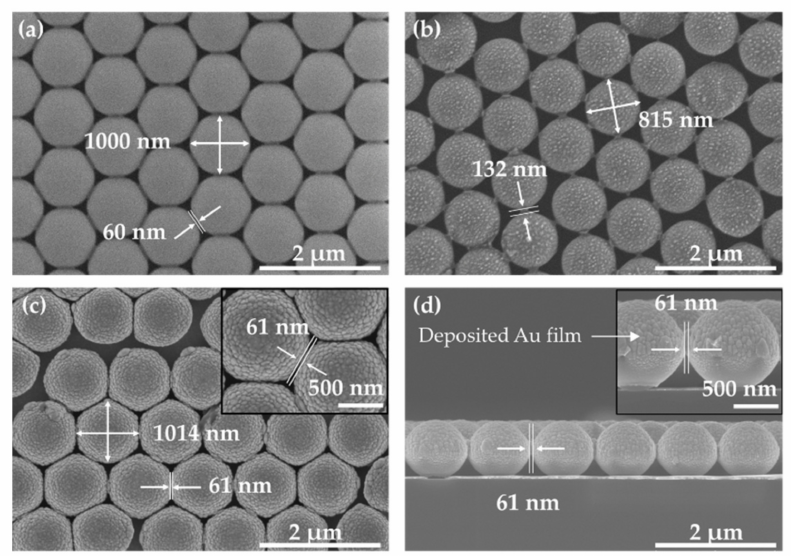
Figure 10. FE-SEM images of: ( a ) as-prepared 2D periodic nanopattern template, ( b ) modified template, and ( c ) and ( d ) MEF substrate.